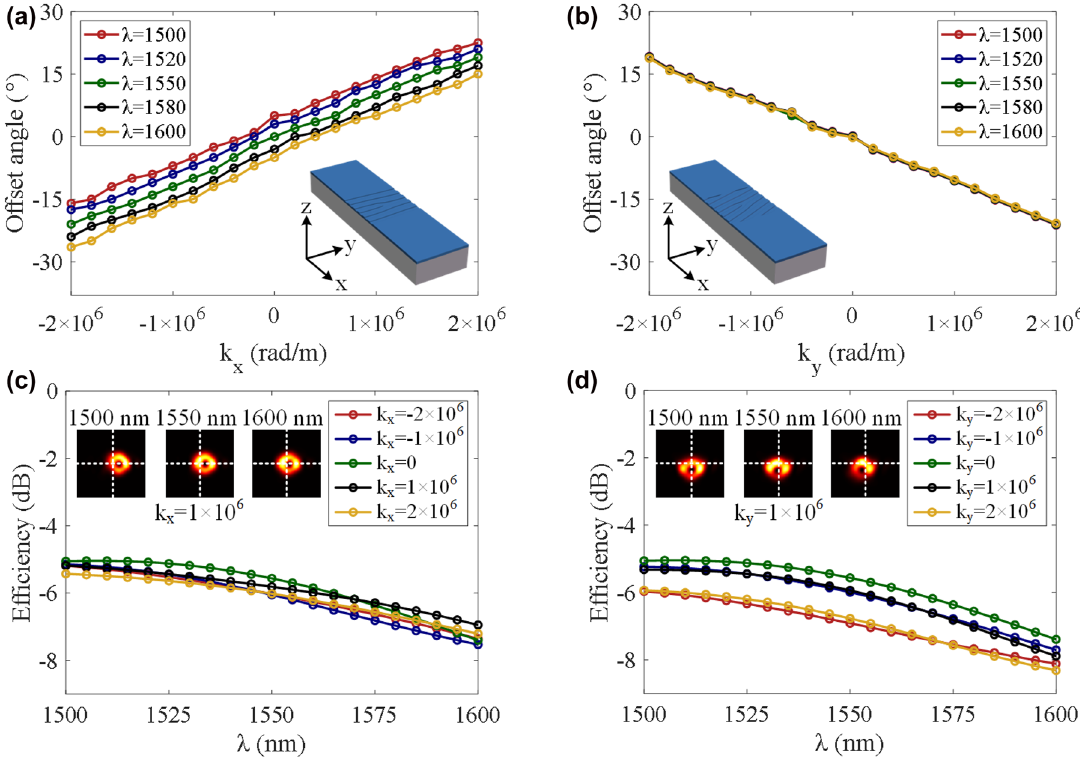
Figure 6: Simulated offset angle and scattering efficiency. (a, b) Offset angle versus additional linear phase gradient in the x -axis and y -axis at different wavelengths. (c, d) Simulated efficiency versus wavelength with different additional linear phase gradients in the x - and y -axis, respectively.